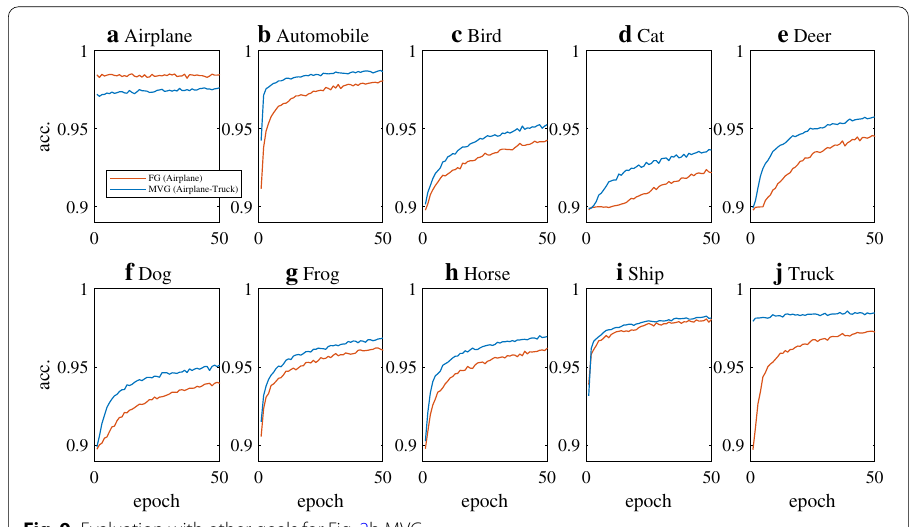
Fig. 9 Evaluation with other goals for Fig. 2b MVG